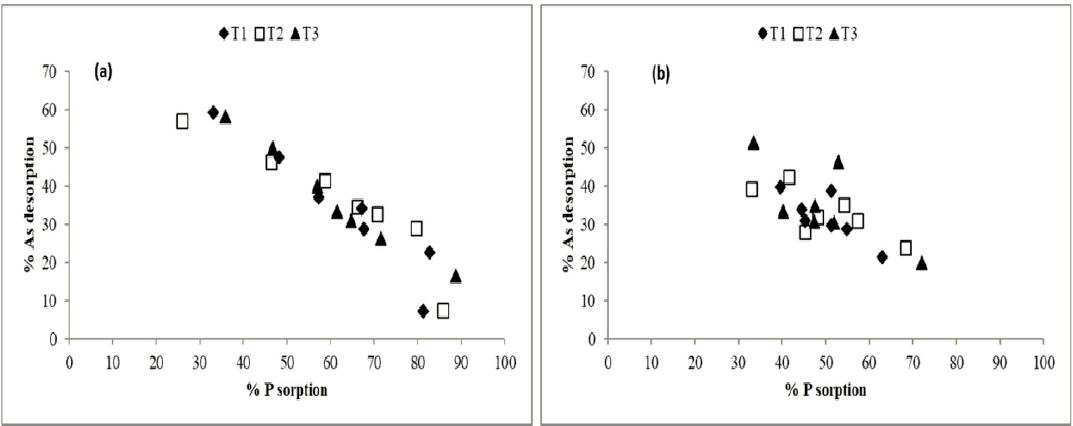
Figure 7. Percentage As desorption in relation to percentage P sorption. ( a ) Soil 1 ( b ) Soil 2. T1: triple phosphate in water, T2: triple phosphate in 0.01 M NaNO 3 , T3: NH 4 H 2 PO 4 in 0.01 M NaNO 3 .